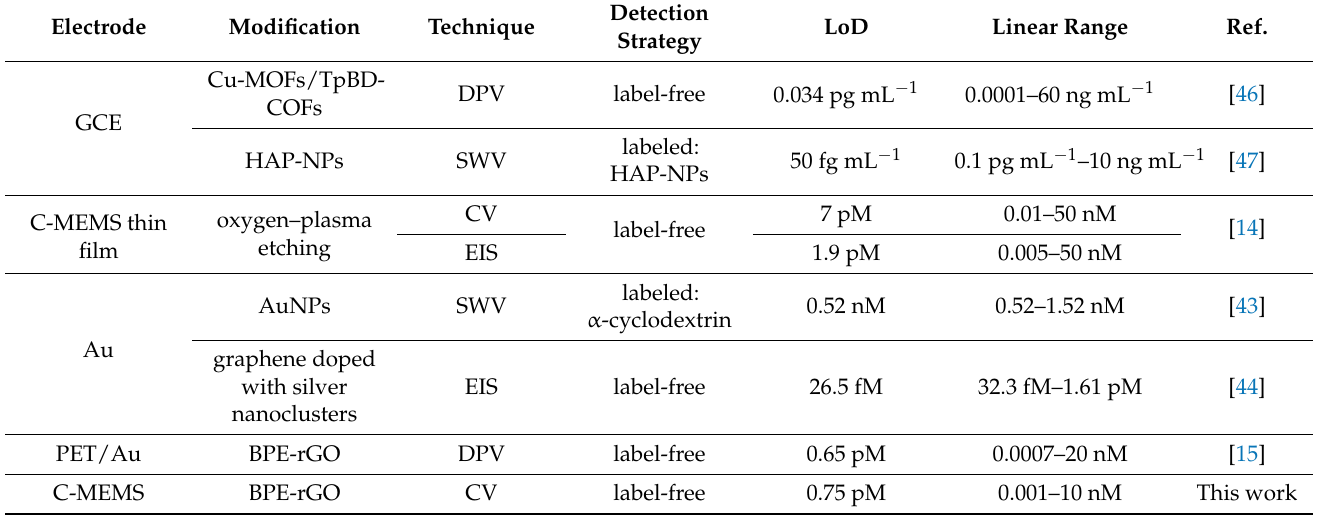
Table 1. The performance of recent electrochemical PDGF-BB